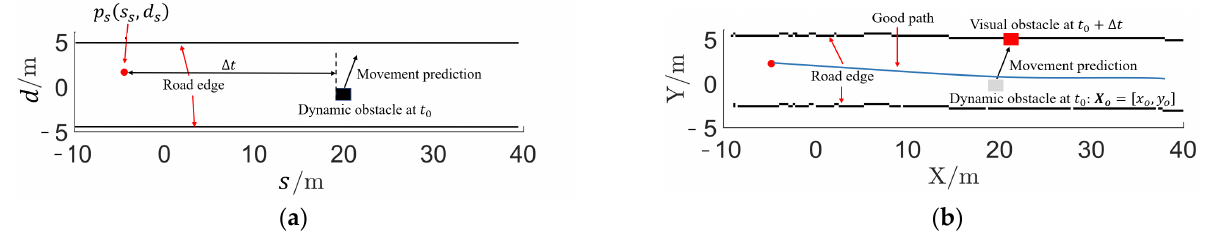
Figure 3. An example dynamic scenario. ( a ) Environment model under Frenet coordinate system; ( b ) virtual obstacle and an example planned path at time t + ∆ t .